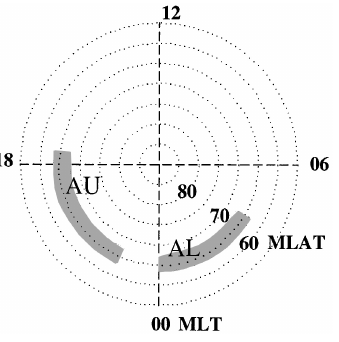
Fig. 11. The MLT regions (marked with gray shadings ) where the local EISCAT chain gives a good estimate for the global activity (i.e. when E (cid:65)(cid:85) ( 0.2 or E (cid:65)(cid:76)